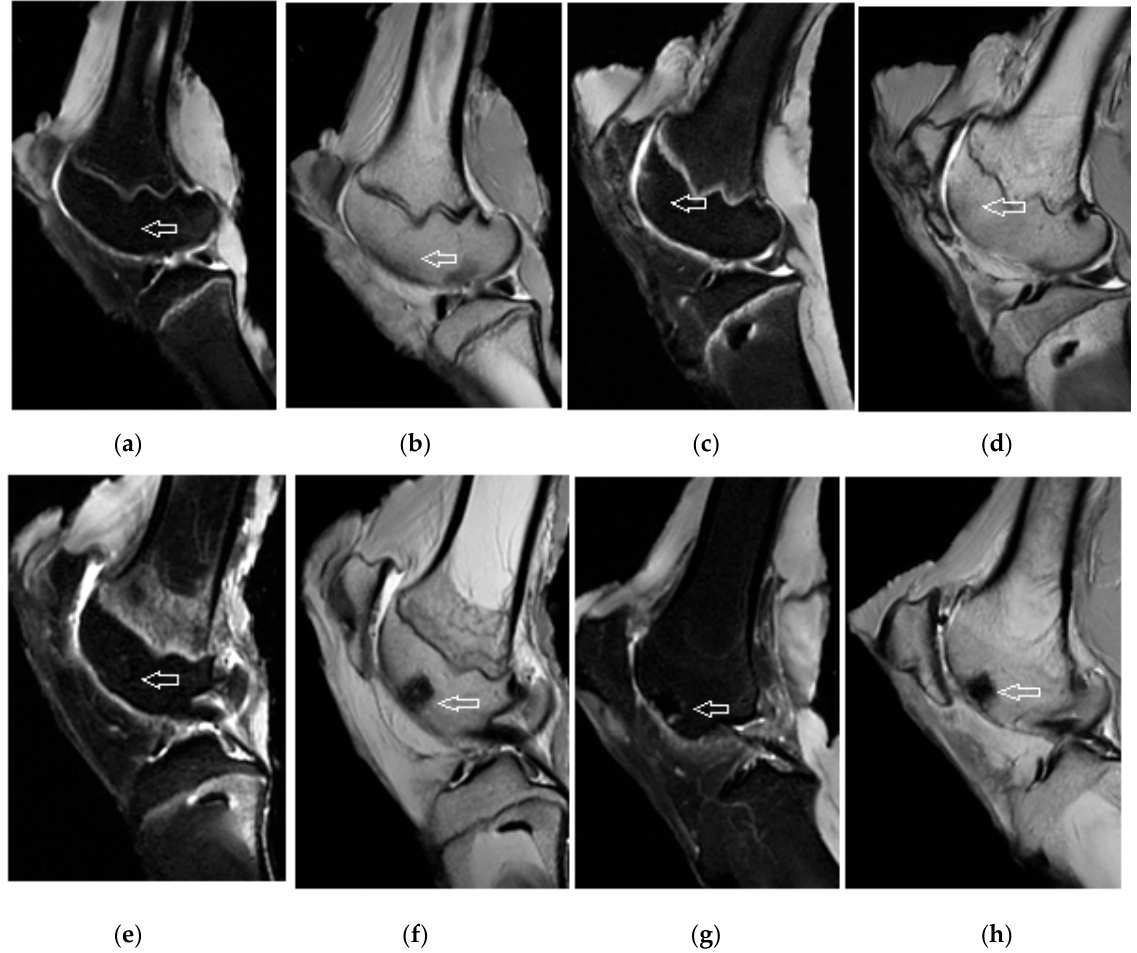
Figure 7. MRI of osteochondral defects treated with novel CAL biomaterial. ( a – d ) 6 months post-operation, MR images demonstrated complete defect filling with newly formed cartilage tissue at the level of surrounding cartilage or ( e,f ) slightly depressed, ( a , c , e ) with isointense signal and comparable thickness to native cartilage in T2-weighted fat-suppressed MR images. ( b , d , f ) The signal of trabecular bone in T1-weighted sequences was altered indicating bone remodelling with signs of subchondral sclerosis typical for the healing process. No signs of perifocal reactive bone oedema and no degenerative changes were observed. ( g , h ) MRI of osteochondral defect treated with C biocement. The thin margin of residual perifocal bone oedema was observed. The arrow indicates the area of healed osteochondral defect created in trochlea ossis femoris 6 months after surgery.